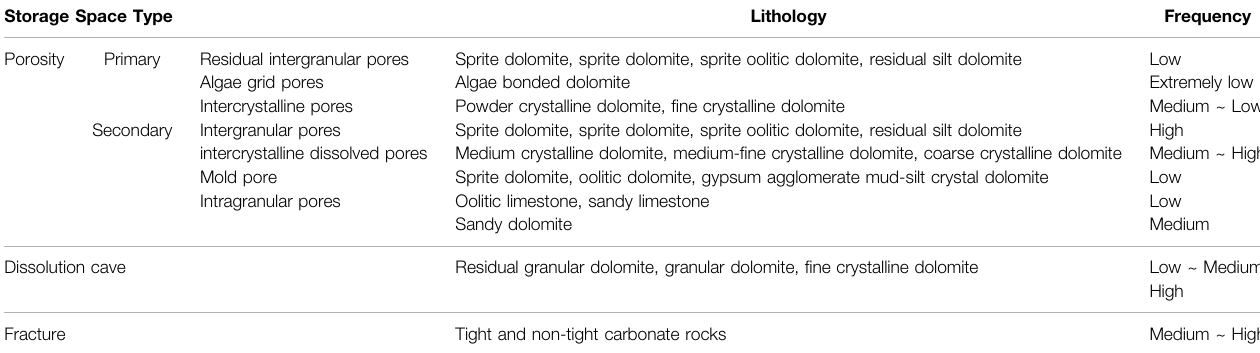
TABLE 4 | Reservoir space type and distribution frequency summary table of the Cambrian Longwangmiao Formation in the Sichuan Basin. Storage Space